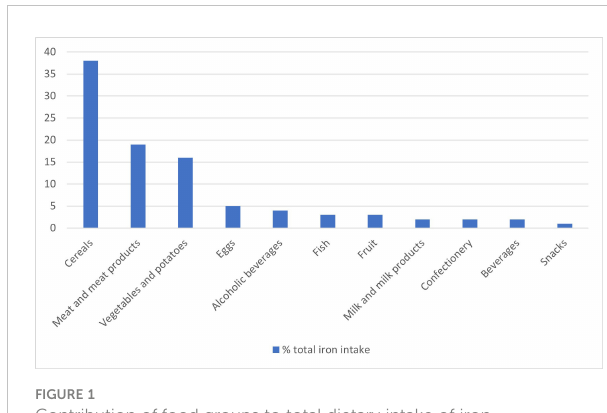
FIGURE 1 Contribution of food groups to total dietary intake of